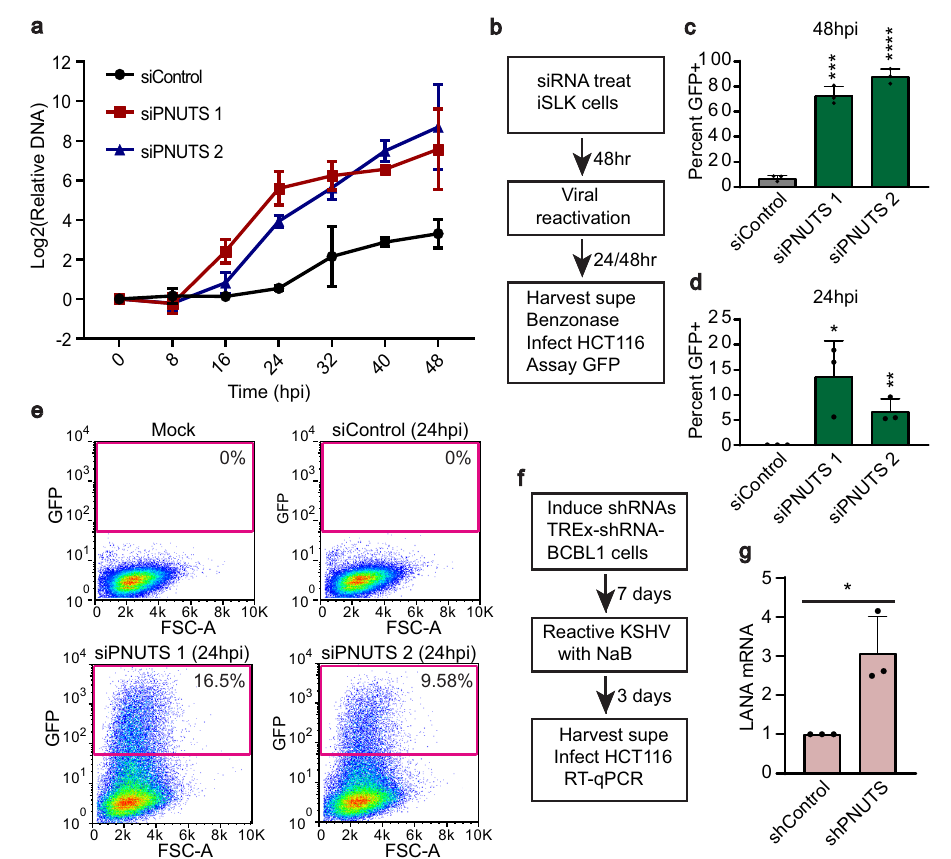
Fig. 3 | Depletion of PNUTS enhances KSHV viral replication. a vDNA content relative to host genome was quanti fi ed by qPCR at various timepoints from 0 to 48hpi in siControl, siPNUTS 1 or siPNUTS 2-treated cells. Error bars are mean with standard deviation, ( n =3). b Schematic of viral replication assay from iSLK cells after PNUTS depletion. c Quanti fi cation of the percent of recipient cells infected with virus produced from non-targeting control versus PNUTS-depleted cells after 48h of lytic induction. Error bars are mean with standard deviation, asterisks denote Student ’ s two-tailed unpaired t-test: (siControl vs siPNUTS 1 *** p =0.0001, siControl vs siPNUTS 2 **** p =2.4×10 − 5 ), ( n =3). d as in c , except from virus har- vested at 24hpi from iSLK cells. Error bars are mean with standard deviation, asterisks denote Student ’ s two-tailed unpaired t-test: (siControl vs siPNUTS 1